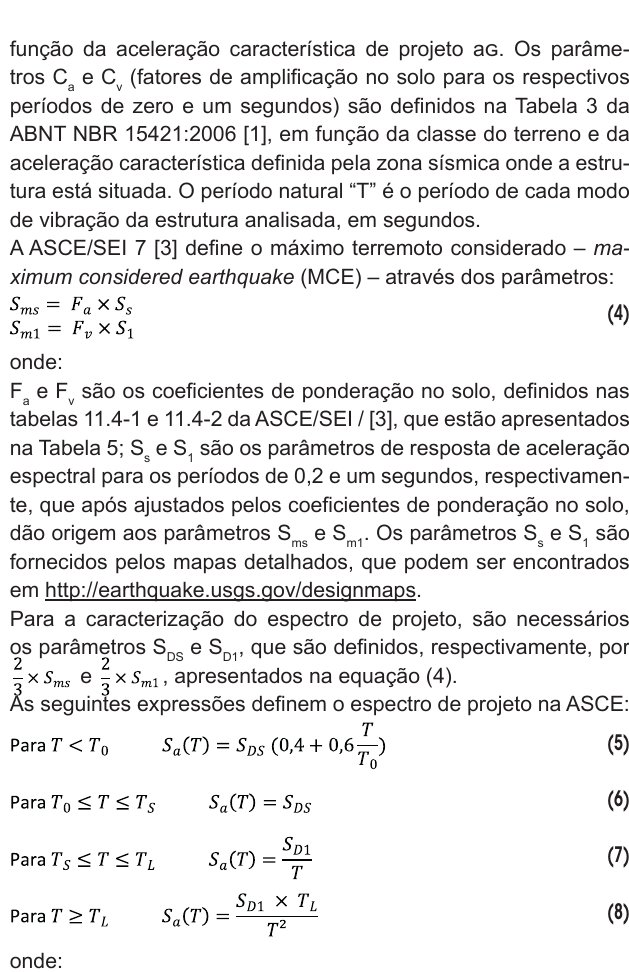
Figura 2 Espectro de resposta elástica, adaptado do Eurocódigo 8